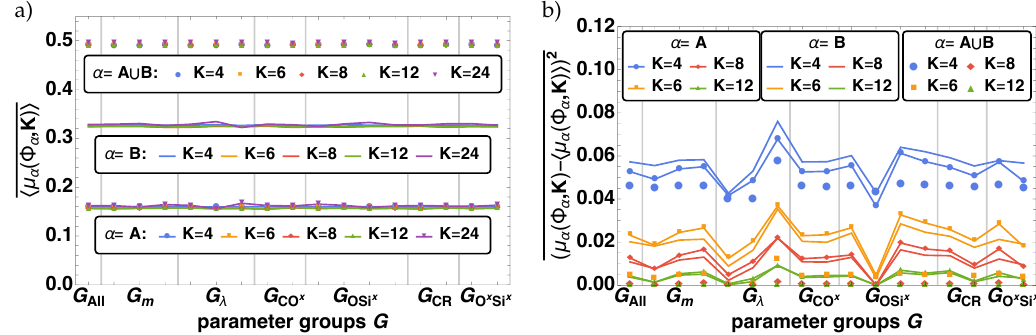
Figure 11. In a) the averaged mean values of the local porosity distribution (cid:104) µ α ( Φ α , K ) (cid:105) and in b) the averaged variances ( µ α ( Φ α , K ) − (cid:104) µ α ( Φ α , K ) (cid:105) ) 2 for different lengths K = { 4,6,8,12 } of the measurement cells for α = { A, B, A ∪ B } are shown over the parameter groups G ( i ) . Note that for K > 12 all variances are 0 and thus are not shown here.